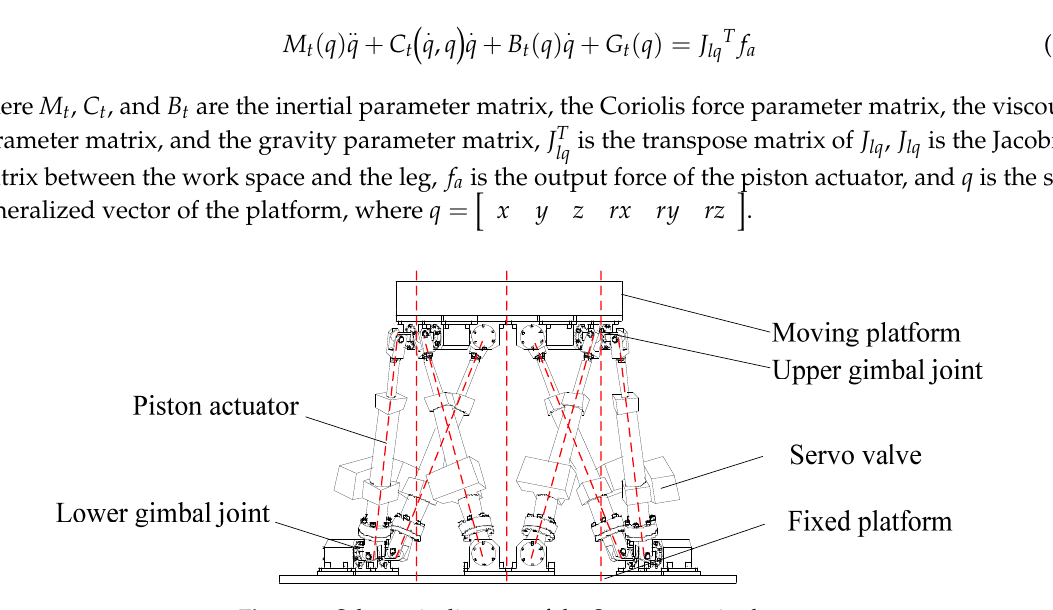
Figure 1. Schematic diagram of the Stewart manipulator.